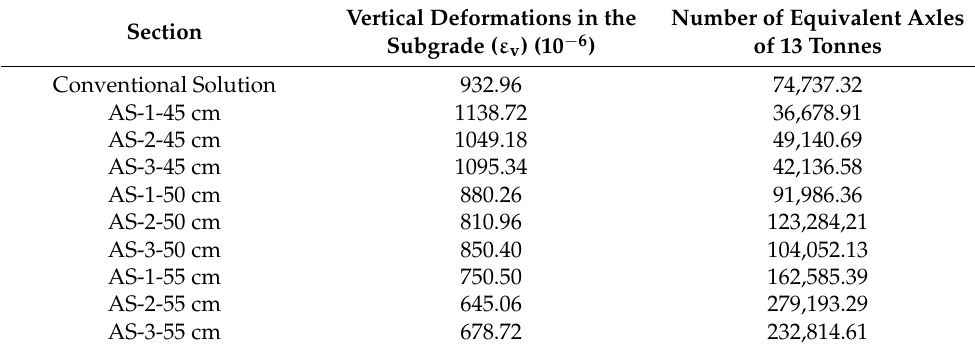
Table 6. Results of the vertical deformations in the subgrade obtained in the multilayers analysis and the number of axles obtained by calculus.